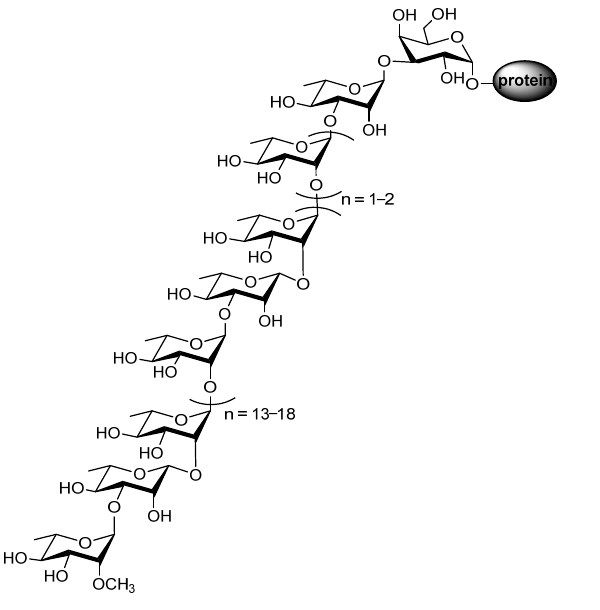
Figure 9. The glycan structure of the Geobacillus stearothermophilus S-layer glycoprotein.